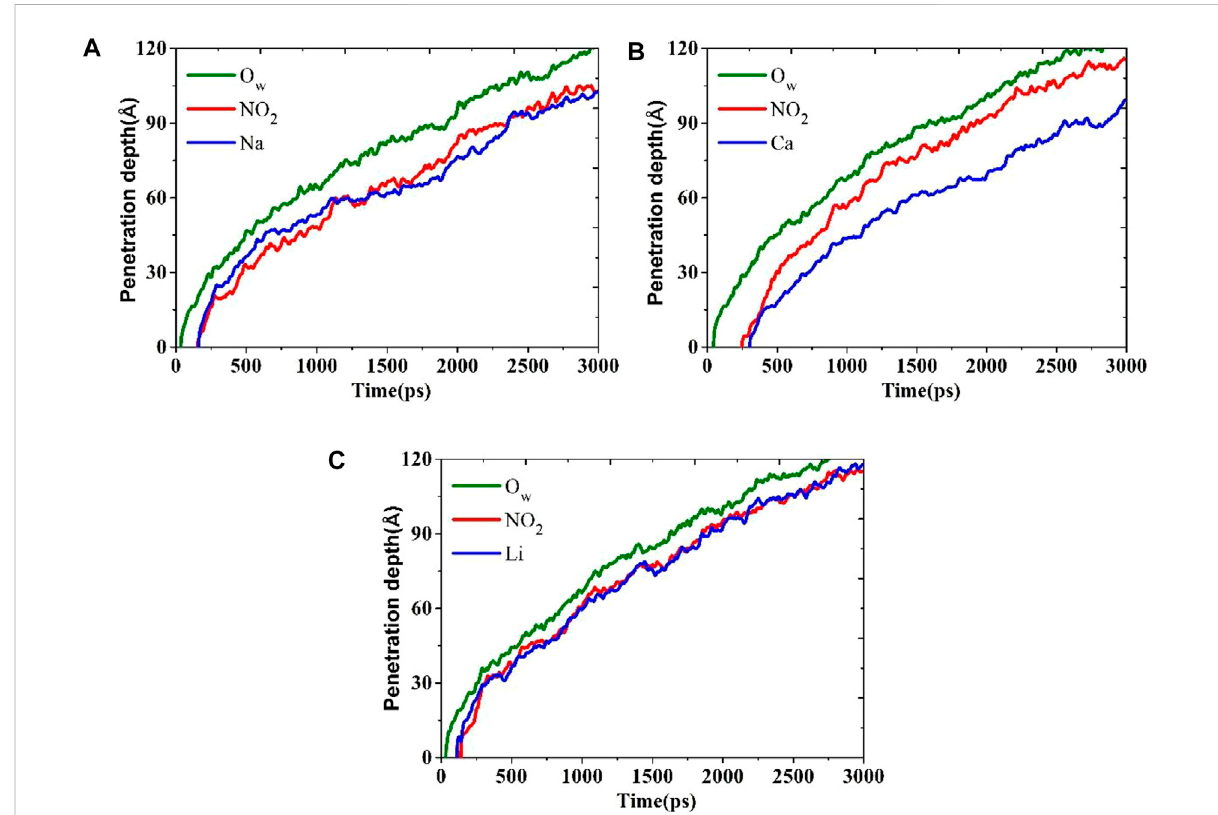
FIGURE 4 Depth of penetration versus time relationship curves: (A) NaNO 2 solution, (B) Ca(NO 2 ) 2 solution and (C) LiNO 2